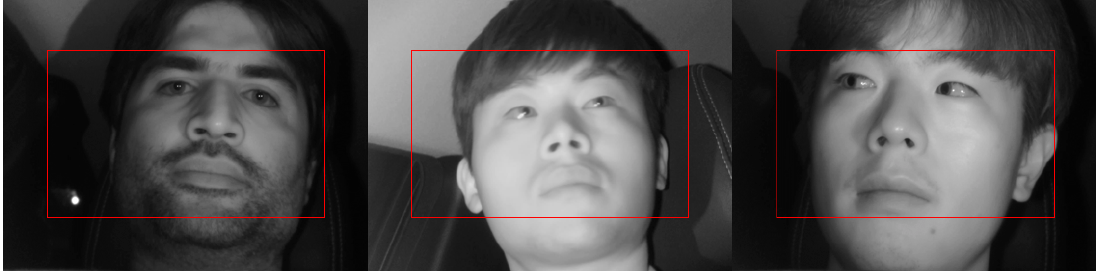
Figure 6. Examples of ROI for the input to faster R-CNN.